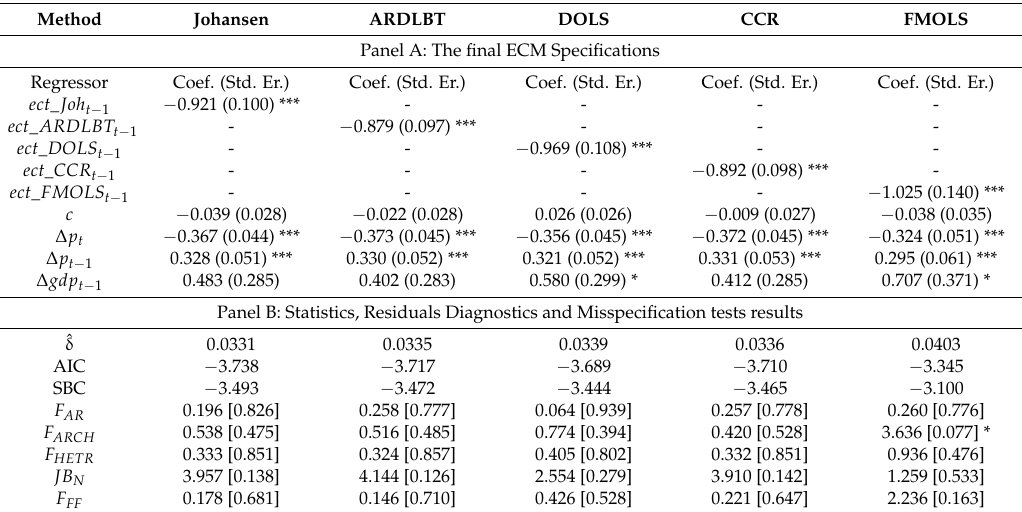
Table 7. Final Error Correction Model Specifications from the